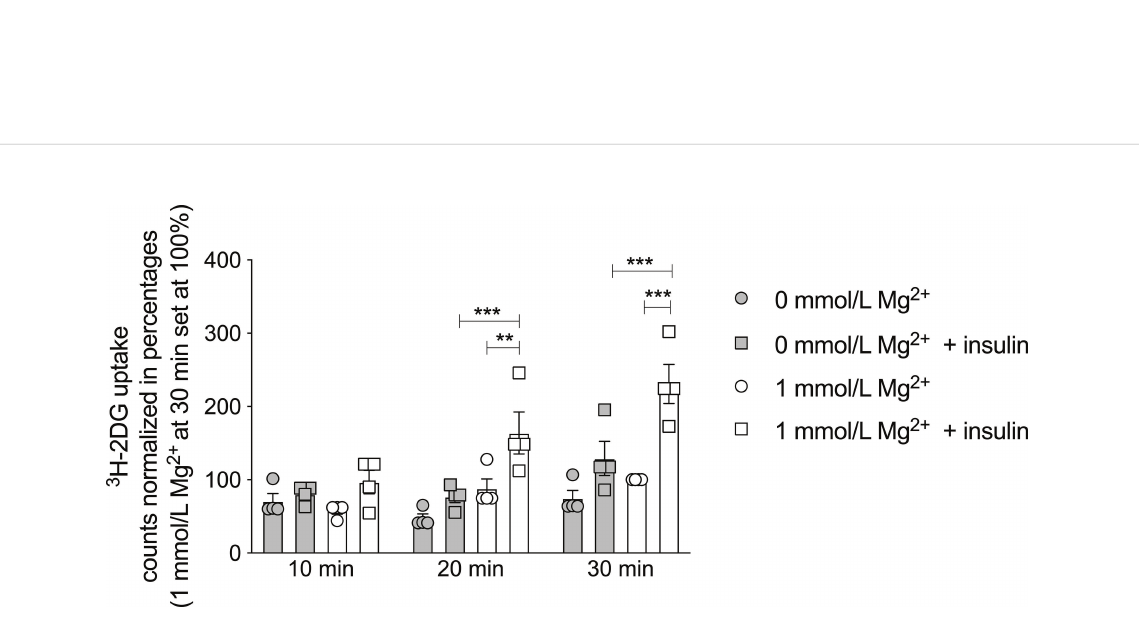
FIGURE 2 Effect of Mg 2+ on insulin-dependent glucose uptake in 3T3-L1 adipocytes. 3 H-2DG uptake for 10, 20 or 30 minutes in 3T3-L1 adipocytes that were incubated with 0 or 1 mmol/L Mg 2+ for 24 hours (n=4). Legend: circle is without insulin, square is with insulin, grey color is 0 mmol/L Mg 2+ and white color is 1 mmol/L Mg 2+ . Data are shown as mean ± S.E.M. Statistically analyzed with Two-Way ANOVA. Signi fi cance **p<0.01; ***p< 0.001. 2DG = 2- deoxyglucose, Mg 2+ , magnesium; min, minutes.